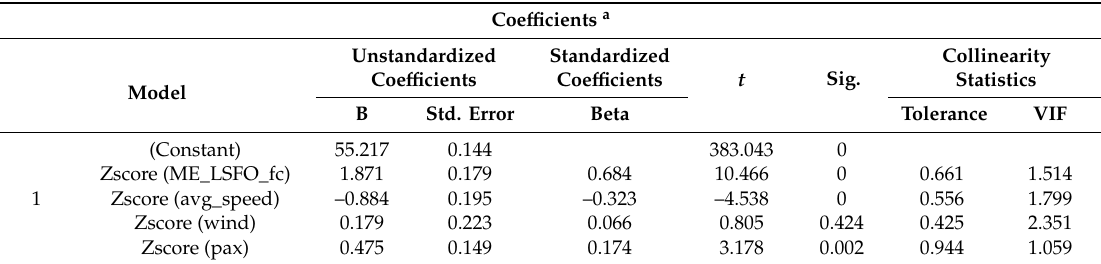
Table 5. Regression analysis outcomes using the enter